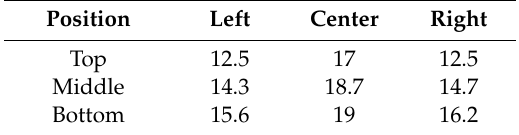
Table 2. Measured irradiance values across the build area (mW / cm 2